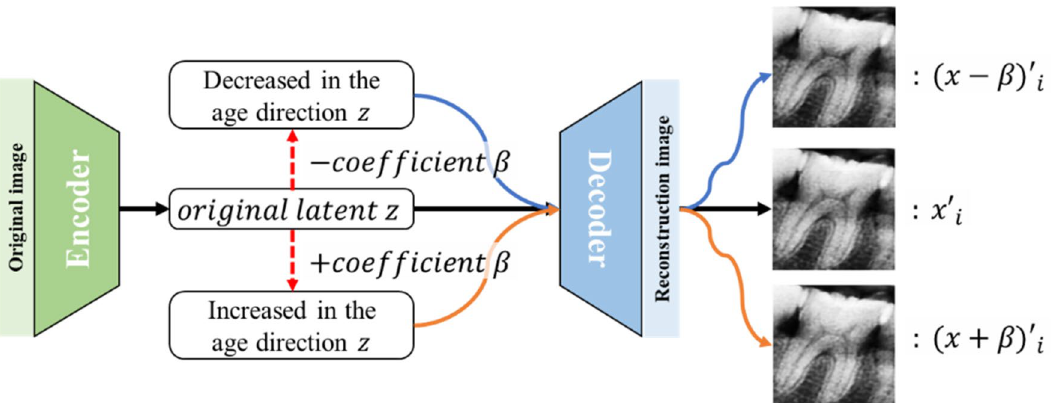
Figure 3. A method for visualizing changes in the morphology of teeth with age using the coefficients obtained from the trained linear regression model. β, the coefficient of the regression model trained with the latent variables and actual age data, represents the correlation between the latent variables and age. Thus, when adding or subtracting the coefficient β to or from the original latent variables generated from the reference image, the values of the latent variables that have a strong correlation with age tend to change greatly, while the values of those that have a weak correlation with age change less significantly. Therefore, the values of the latent z variable change according to the degree of correlation with age, and this relationship can be visually demonstrated using the